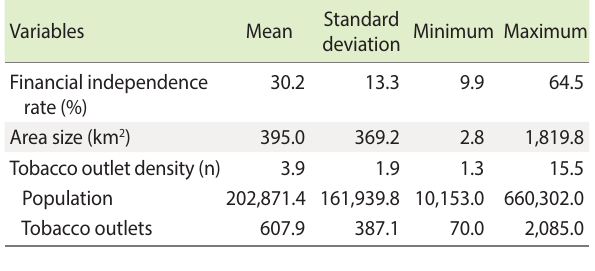
Table 3. Multi-level analysis result of factors associated with